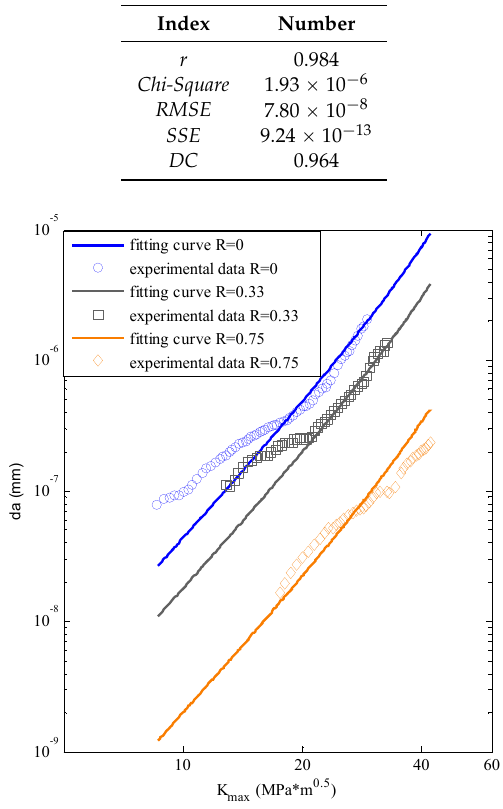
Table 6. The fitting indices of D16.